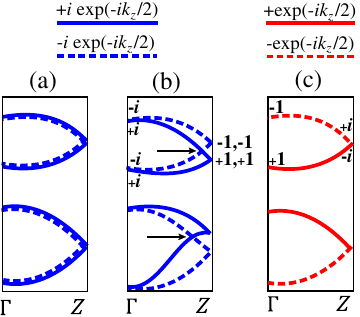
FIG. 14. Bulk band structures with glide and time-reversal symmetries, for systems with spin (a),(b) and without (c). Γ ≡ ð 0 ; 0 ; k 0 Þ and Z ≡ ð 0 ; 0 ; k π Þ are high-symmetry z ¼ z ¼ points that are selected because the fractional translation (in the glide) is parallel to ~z . Panel (a) either has no spin-orbit coupling or has spin-orbit coupling with an additional spatial-inversion sym- metry. Panel (b) has spin-orbit coupling but breaks spatial- inversion symmetry. The crossings between orthogonal mirror branches (indicated by arrows) are movable along Γ Z but unremovable so long as glide and time-reversal symmetries are preserved. Theglide eigenvalues are indicated at Γ and Z for one of the two hourglasses. Panel (c) could apply to an intrinsically spinless system (e.g., bosonic cold atoms and photonic crystals), and also to an effectively spinless system (e.g., a single-spin species in an electronic system without spin-orbit